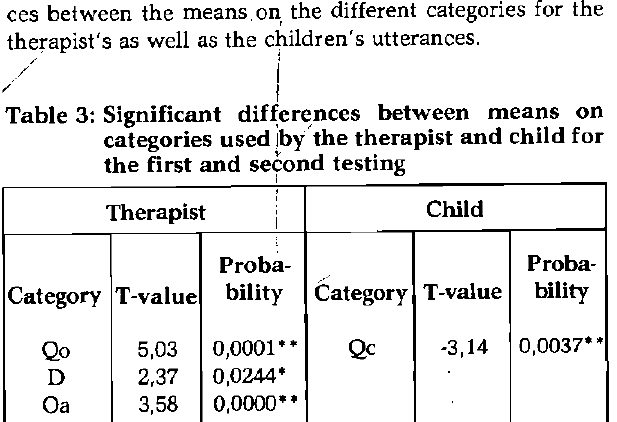
Table 4: Test for the difference in means between the two groups (children that failed and passed) with respect to the story variables